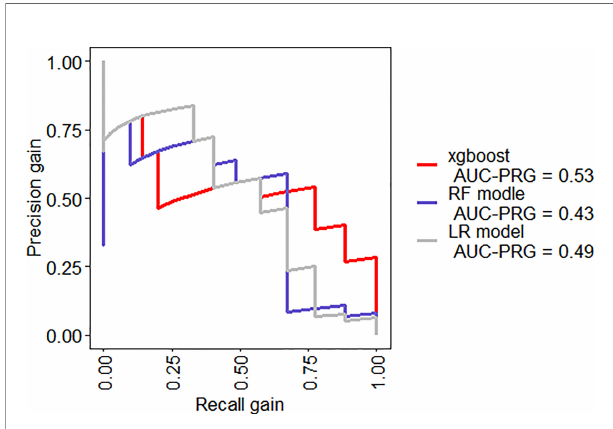
FIGURE 8 | Precision recall gain curves for the XGBoost, RF model, and LR model.